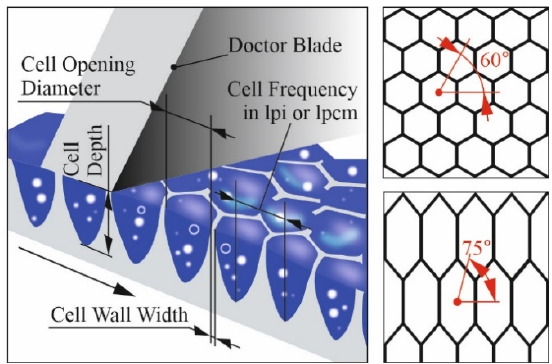
Figure 6. Anilox roller cell geometry parameters and typical cell engraving angles.